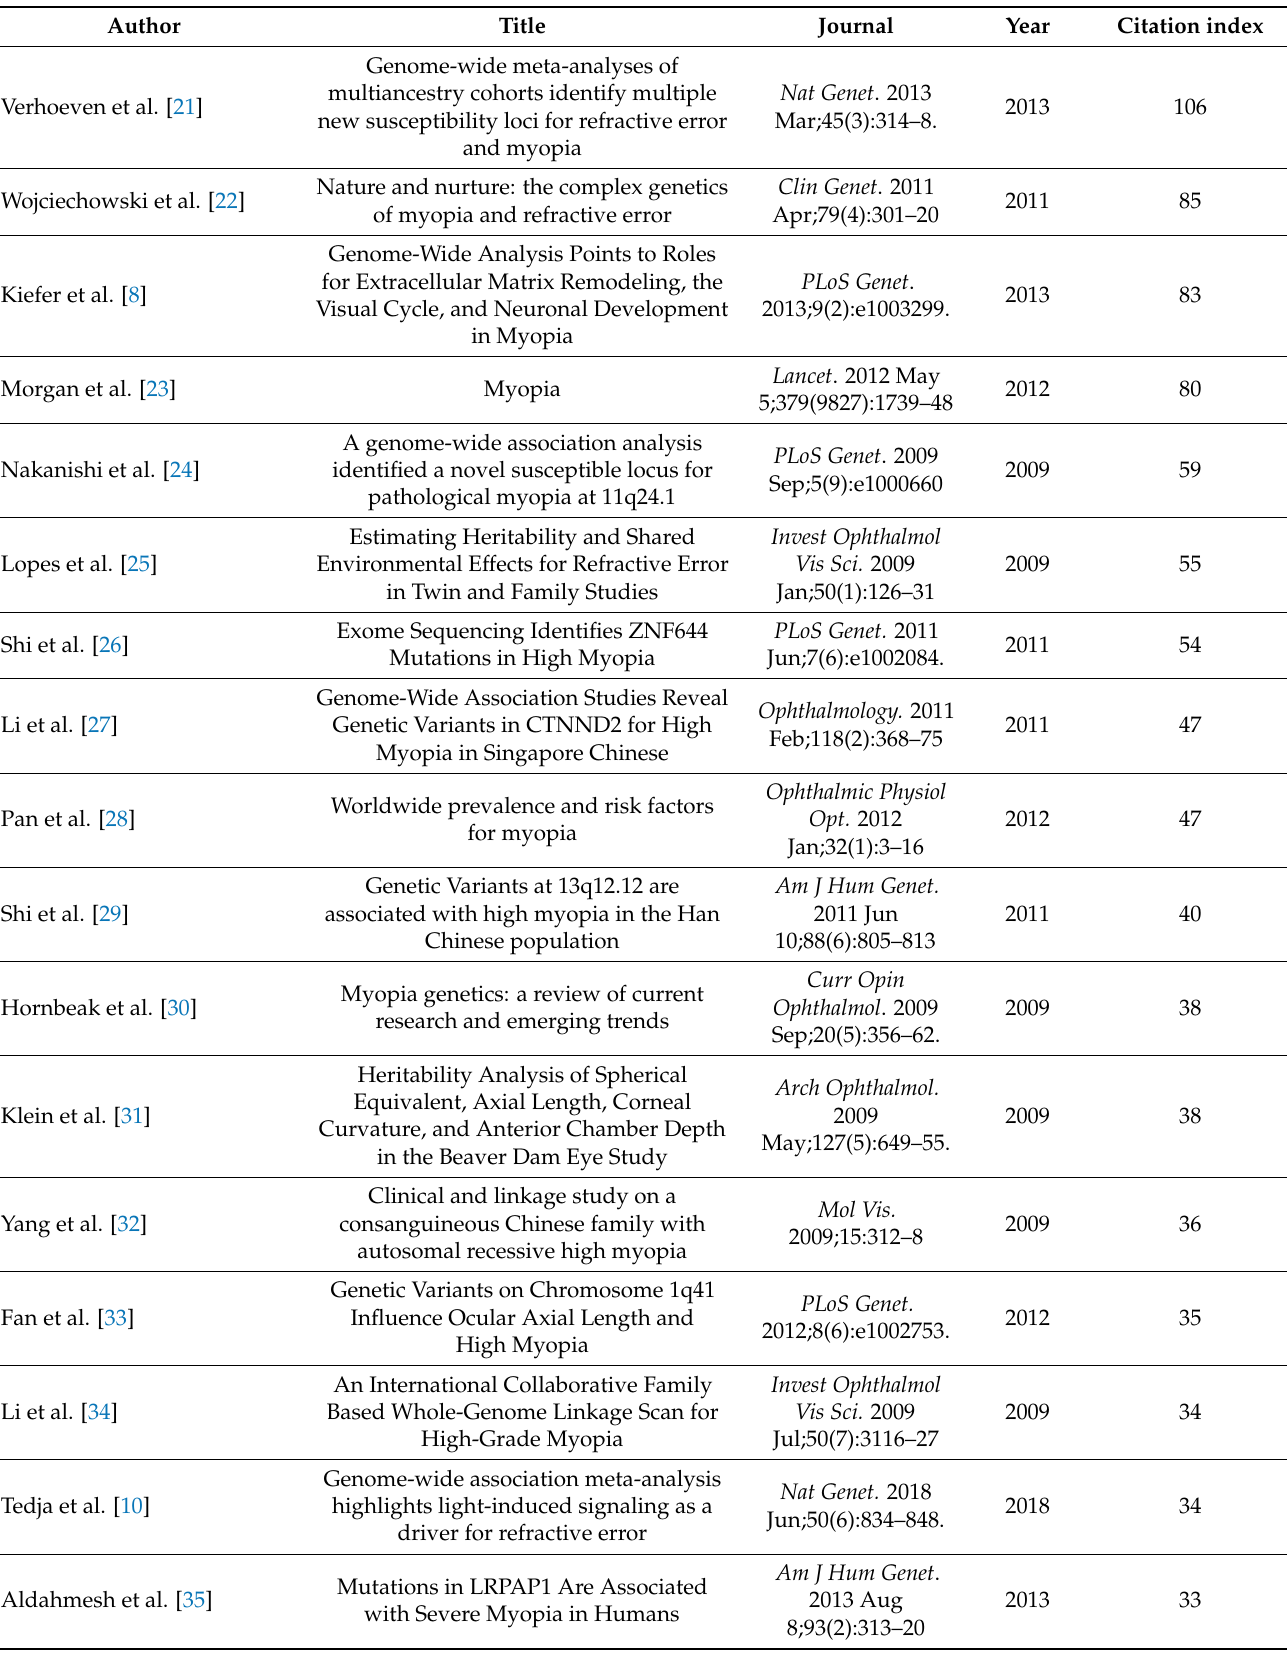
Table 8. The 20 most mentioned